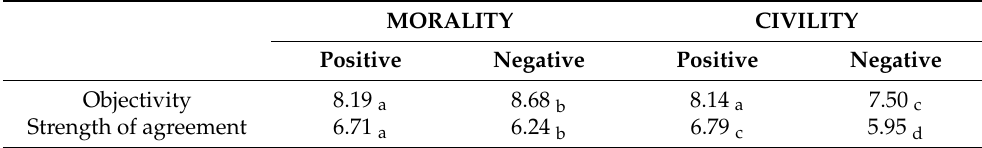
Table 1. Means in objectivity and strength of agreement for each type of